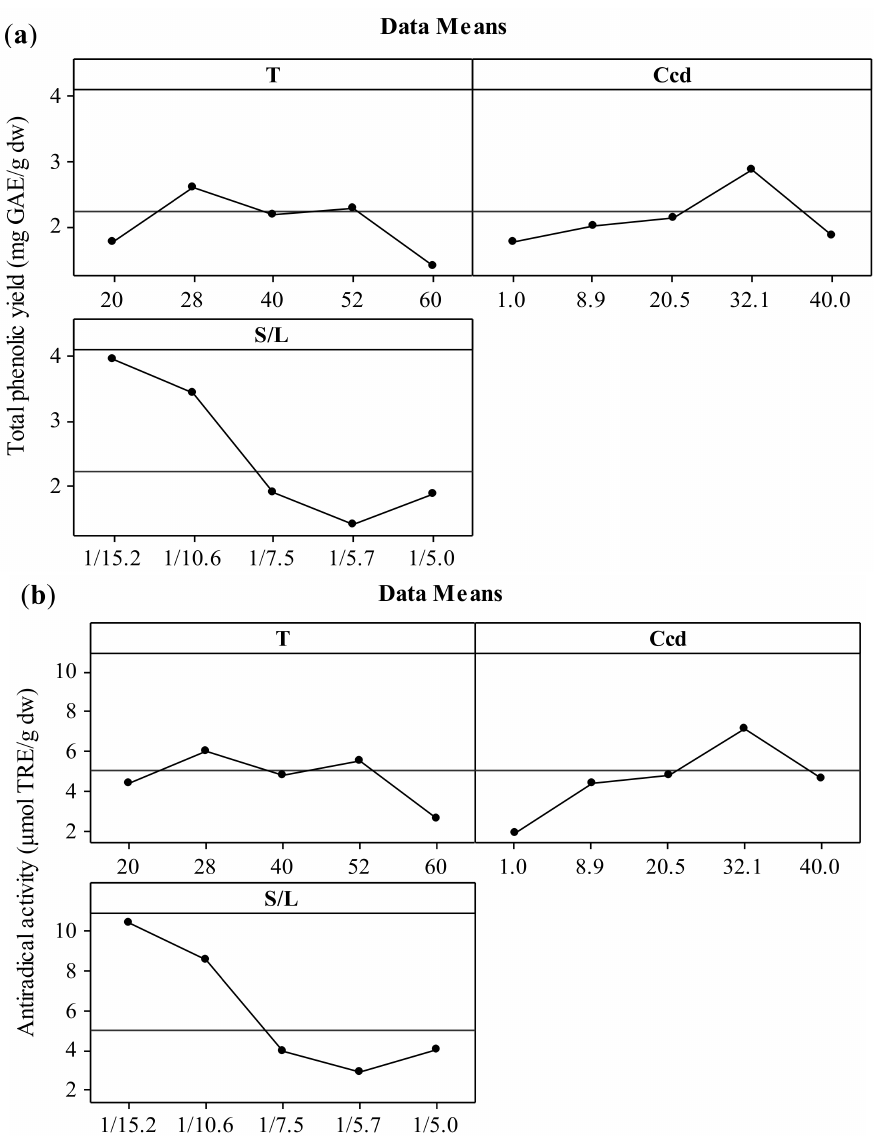
Figure 1. Main effects plots illustrating the effect of extraction temperature ( T ), CD concentration ( C CD), and solid-to-liquid ratio ( S/L ) on the extraction yield ( YTP ) ( a ) and the antiradical activity ( AAR ) ( b ) during extraction of polyphenols from hemp waste for 180